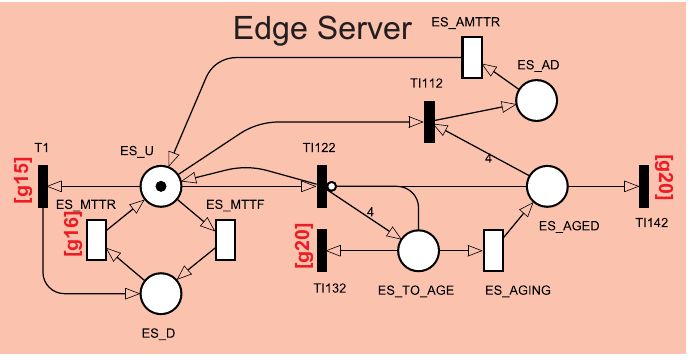
Figure 5. Software aging